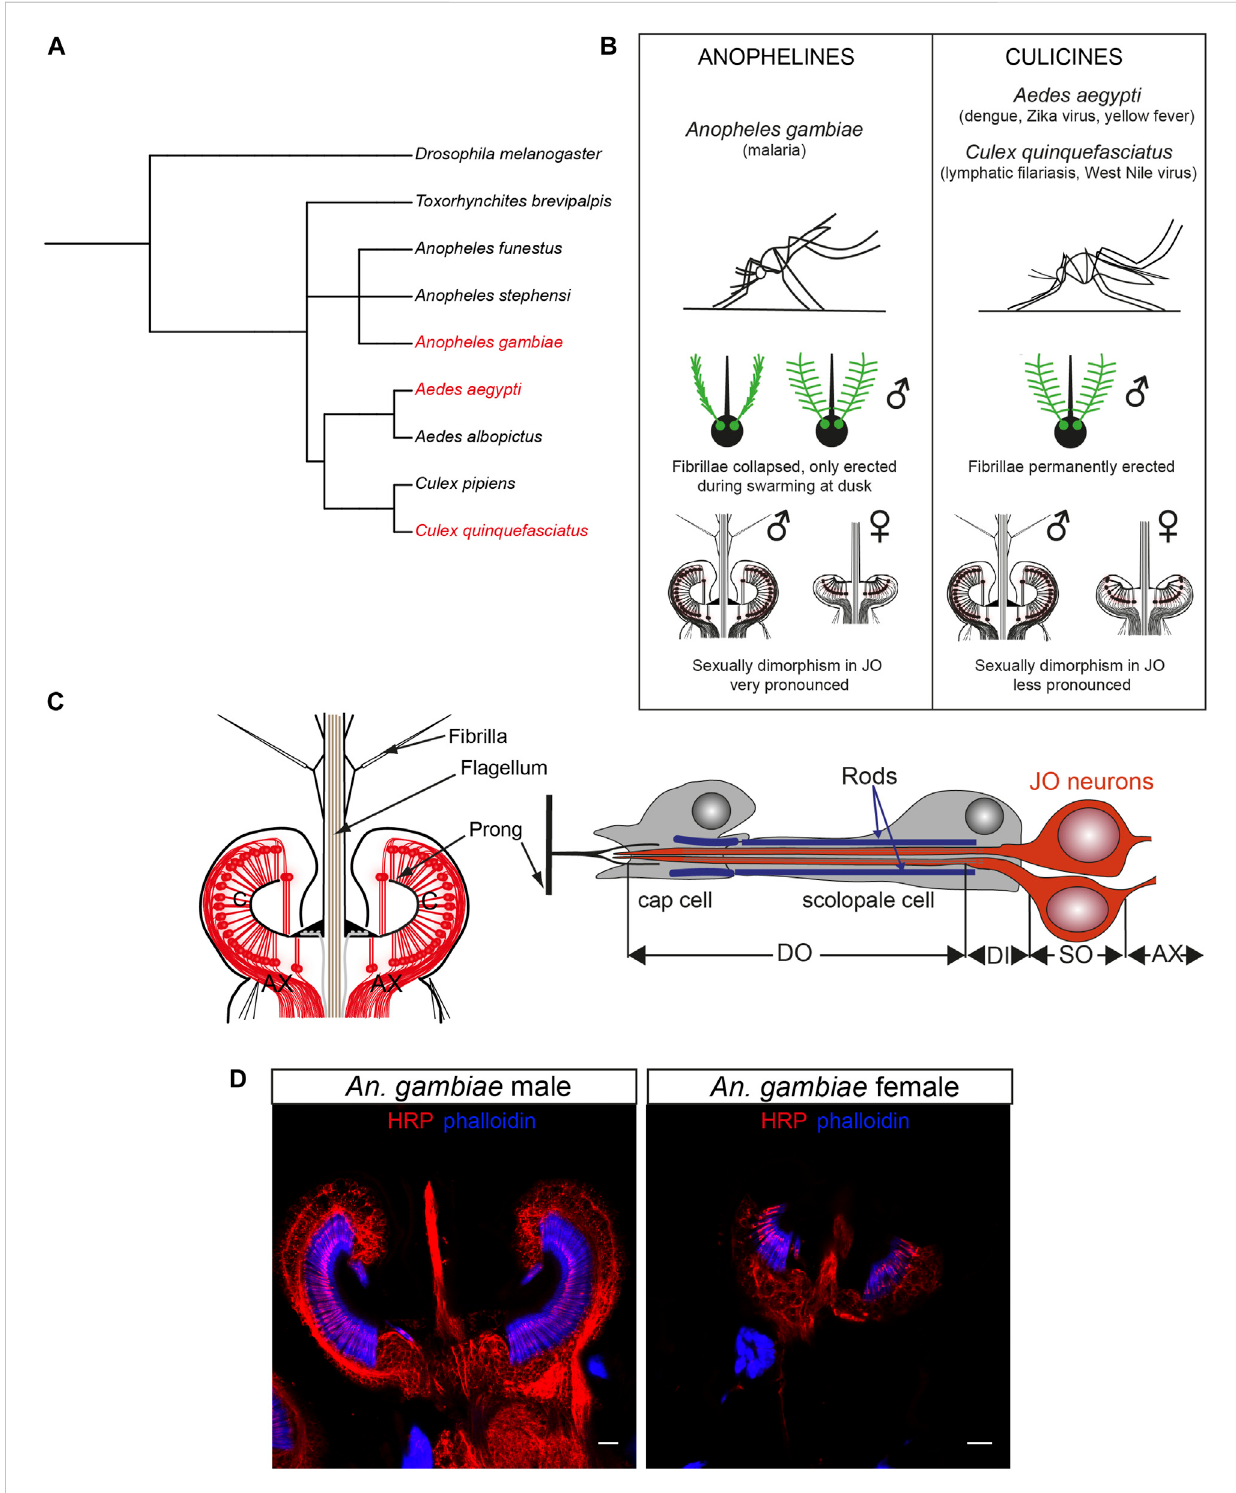
FIGURE 1 Mosquito auditory systems. (A) Phylogenetic tree of mosquito evolution including the three medically-relevant species reviewed in this manuscript ( Ae.aegypti,An.gambiae,Cx.quinquefasciatus ),othermosquitospeciesandthemodelorganism D.melanogaster .MadewithPhyloT. (B) Summaryofthe main differences between anopheline ( An. gambiae ) and culicine ( Ae. aegypti, Cx. quinquefasciatus ) mosquitoes relevant for hearing research. (C) Schematic of the mosquito JO (left) and a single type A scolopidium (right) depicting two auditory neurons, supporting cap and scolopale cell. Modi fi ed from (Andrés et al., 2016). (D) Sexual dimorphism in male (left) and female (right) An. gambiae JOs stained with neuronal marker anti-HRP (red) and phalloidin (F-actin marker, blue) that binds to actin rods in scolopale cells surrounding the auditory cilia. The female ear is smaller and less complex than the male counterpart. Scale bar: 10 µm. AX: afferent axons; C: auditory cilia; DI: dendritic inner segment; DO: ciliated dendritic outer segment; JO: Johnston ’ s organ; SO: